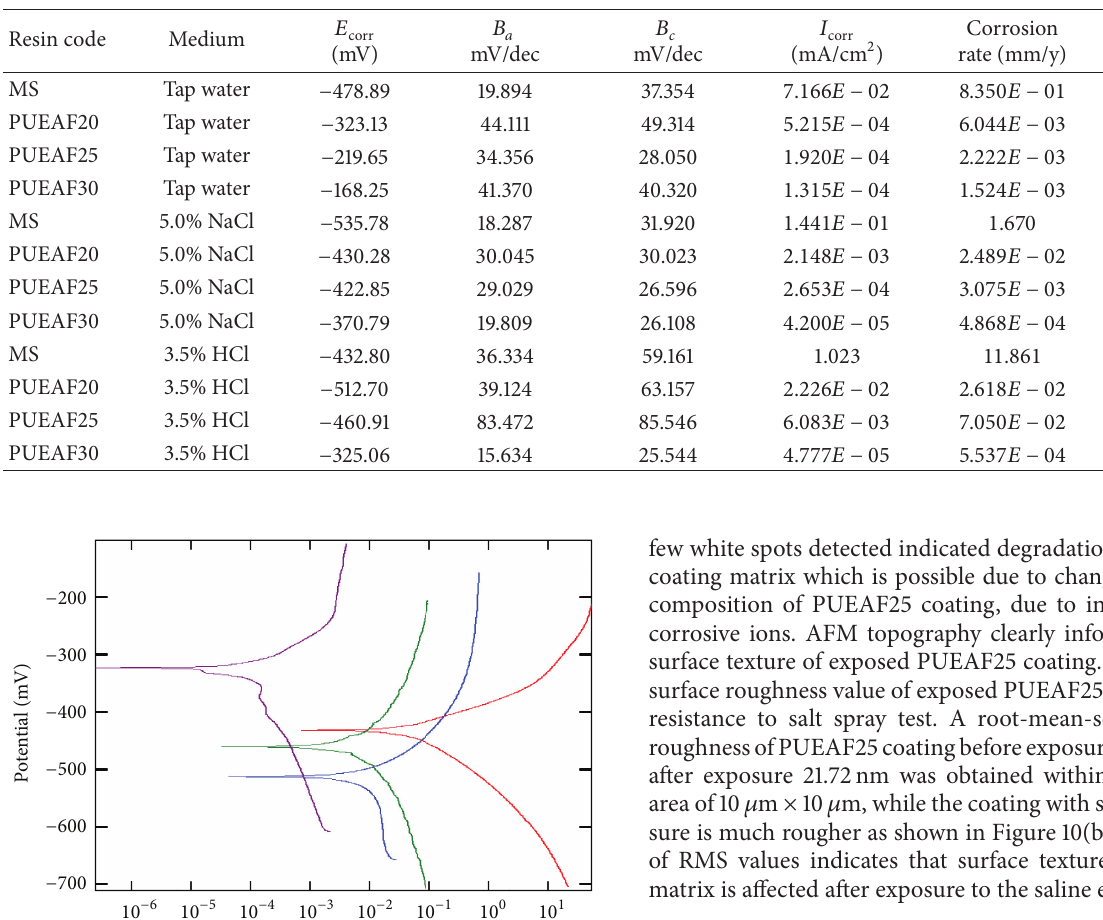
Table 2: Corrosion parameter for PUEAF coated and bare MS in different corrosive media.